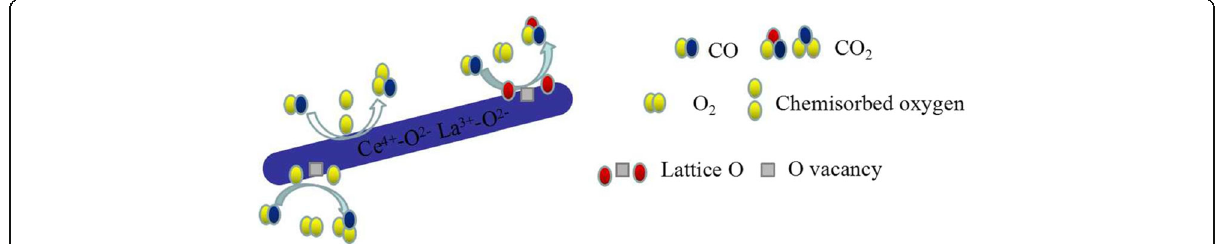
Fig. 14 Proposed CO reaction pathways over the catalysts, Au/Ce-La